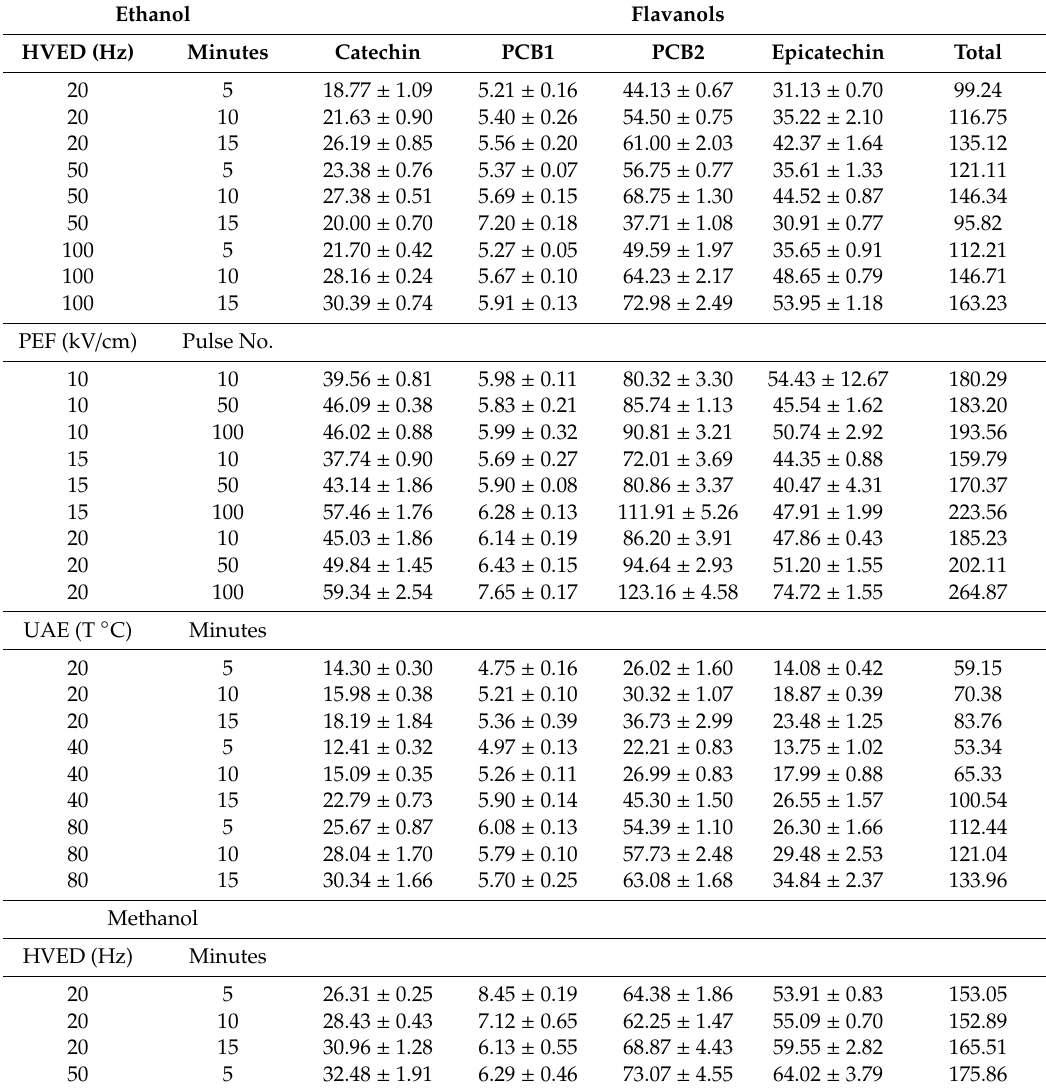
Table 4. Flavanols content ( µ g / g of dw) in the analysed extracts obtained after high voltage electrical discharges (HVED), pulsed electric field (PEF), and ultrasound-assisted extraction (UAE) of blueberry